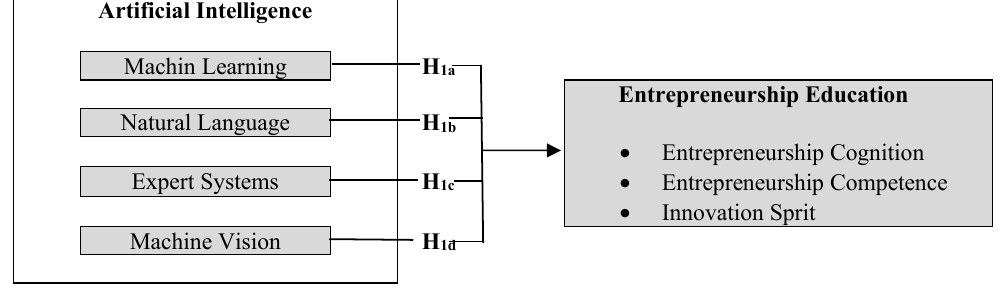
Fig. 1. Conceptual framework